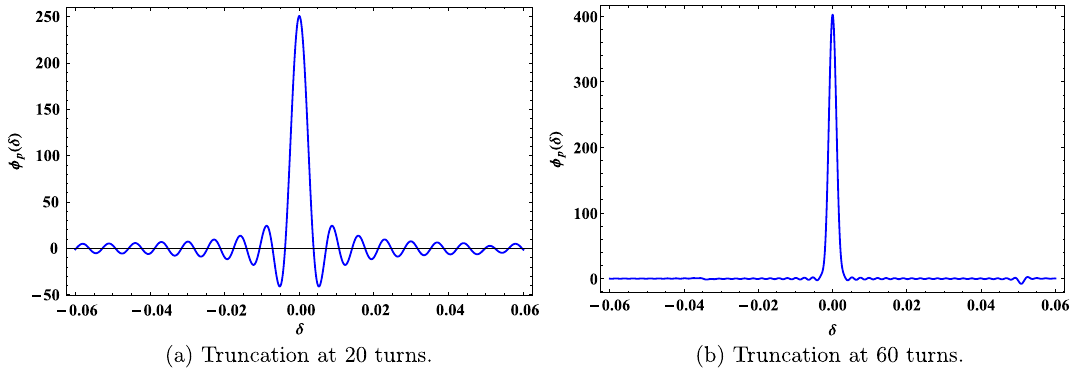
FIG. 5. Plots of the discrete time Fourier transform in cases where the BPM signal is truncated at 20 turns and at 60 turns.